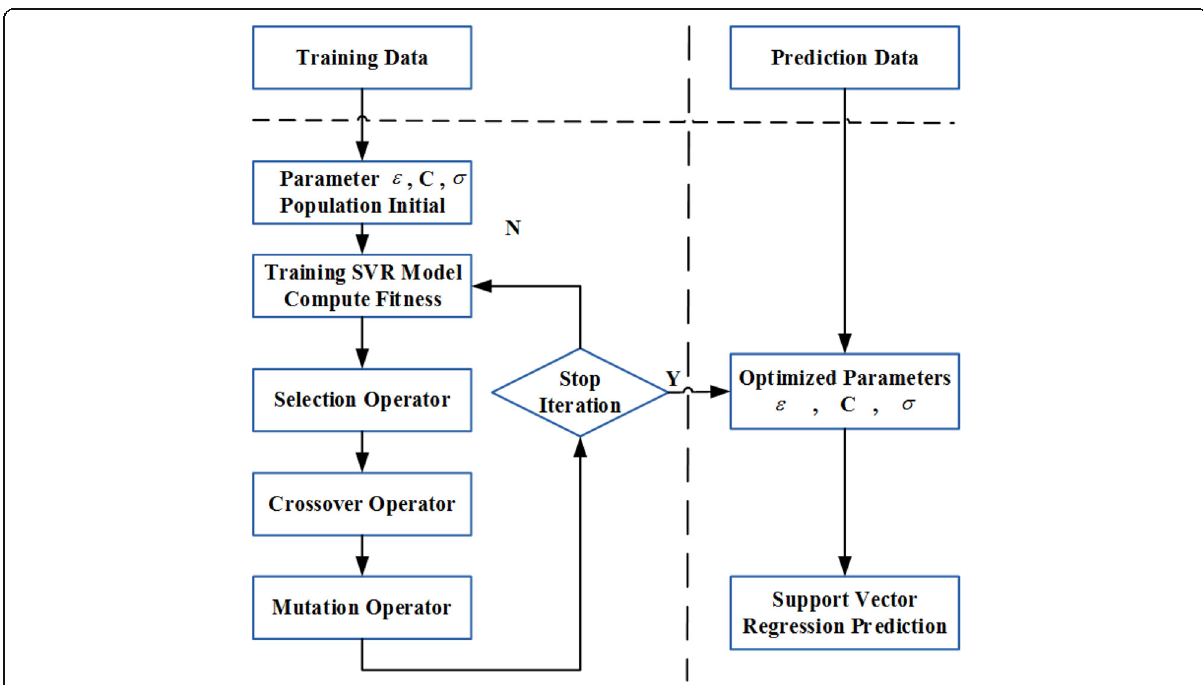
Fig. 1 Flow chart of support vector regression optimized by genetic algorithms